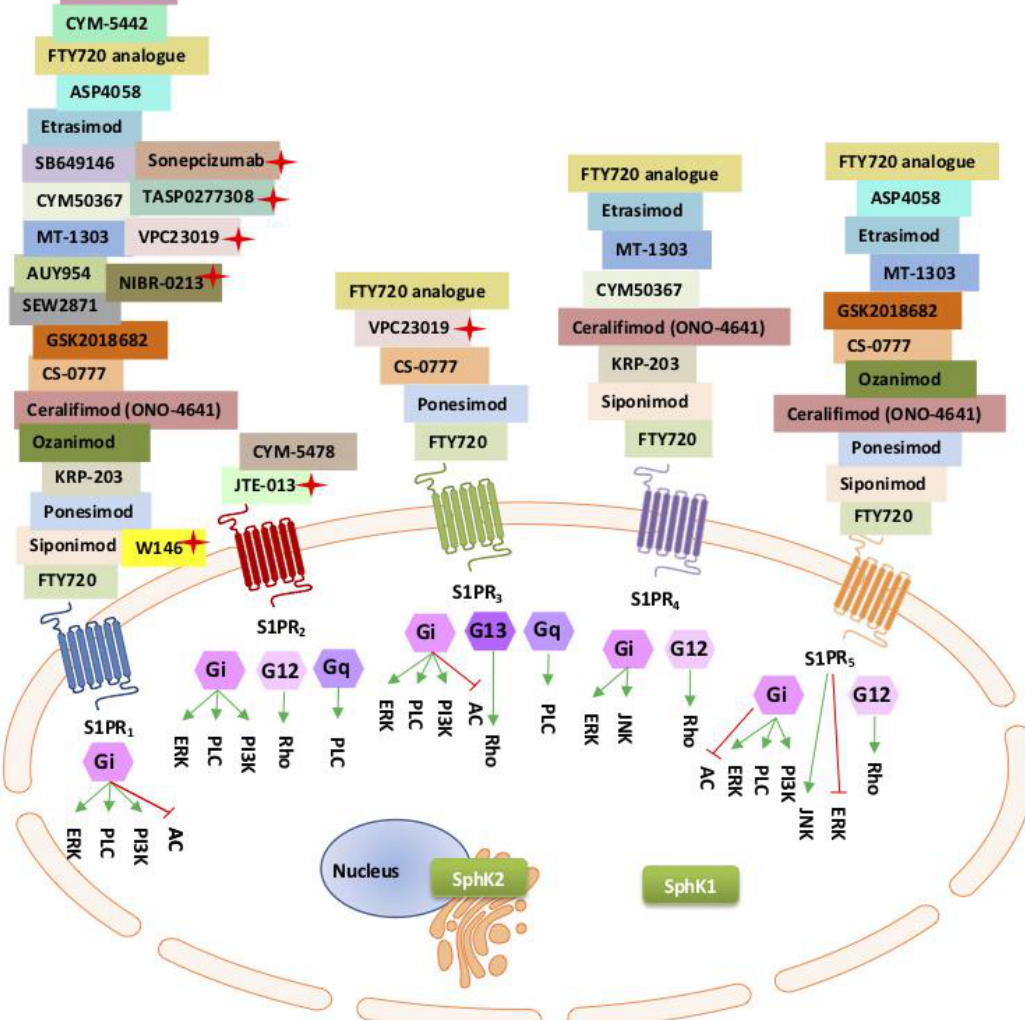
Figure 1. Schematic summary of Sphingosine 1 Phosphate (S1P)/S1PR (G-protein-coupled receptor) agonist and antagonist signalling. There are five S1PR (G-protein-coupled receptors) differentially expressed depending on cell type. Diversity of intracellular signalling is dependent on the differential targeting and binding of S1P to the S1P receptors, which results in internalisation of the S1P receptor and Gi-mediated downstream activation of effector pathways. S1P agonists and antagonists (described in Table 1) bind to cognate transmembrane S1PRs on the cell and are designed to block or activate S1PR action. S1P antagonists are depicted with the symbol. Adapted from [102,115].